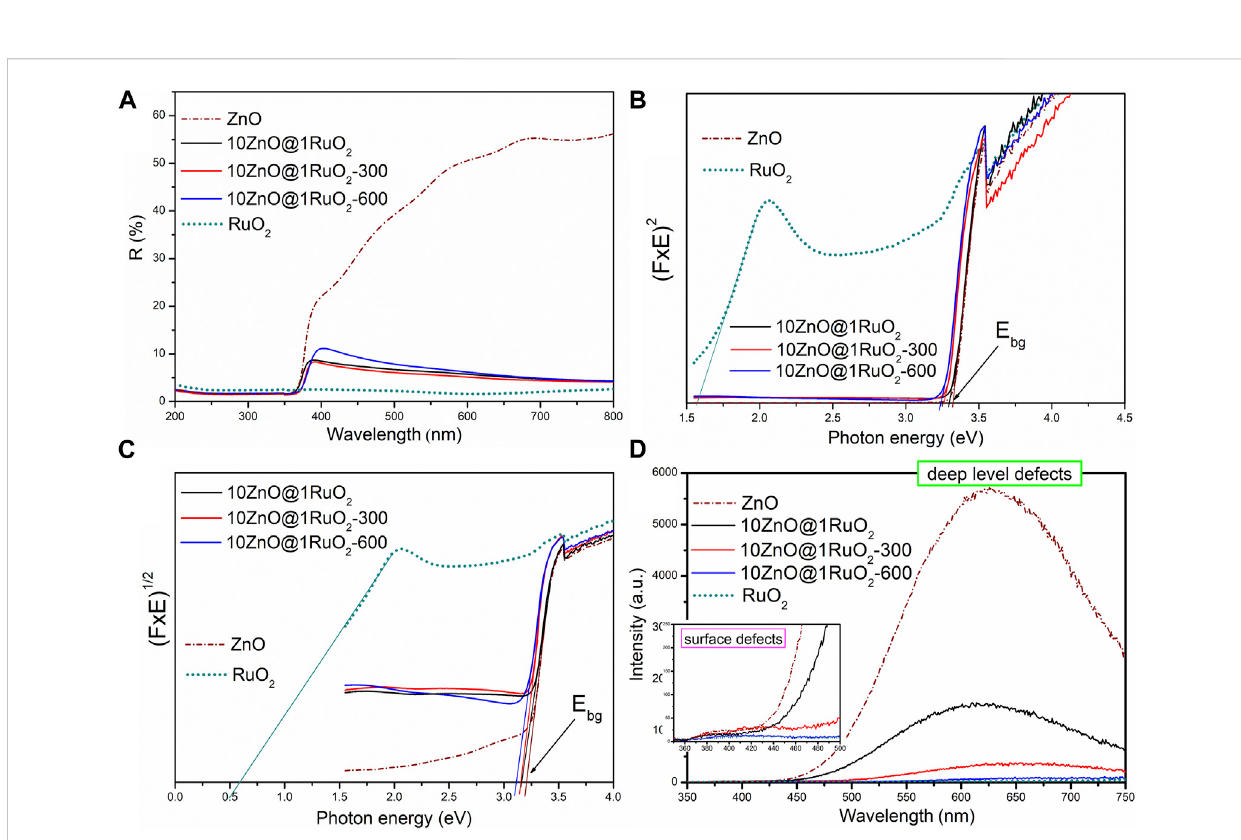
FIGURE 8 (A) UV-Vis DR spectra, (B) Kubelka – Munk plots for direct, (C) indirect bandgap, and (D) PL spectra of the catalyst